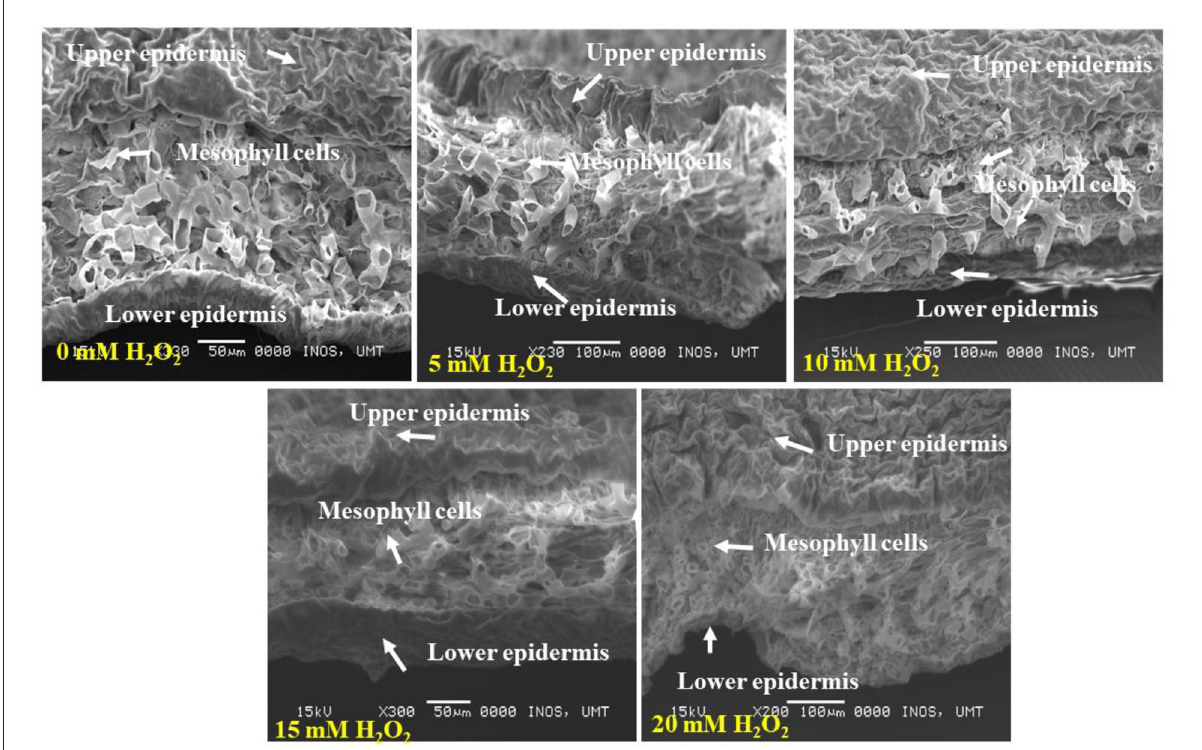
FIGURE6 SEM photographs show the cross section of F. deltoidea leaves under drought stressed condition. The photographs show upper and lower leaf surfaces, each surface consists of an epidermis layer, cuticular wax, and mesophyll cells. Well-developed mesophyll cells are visible in 5mM and 10mM H 2 O 2 treated plant